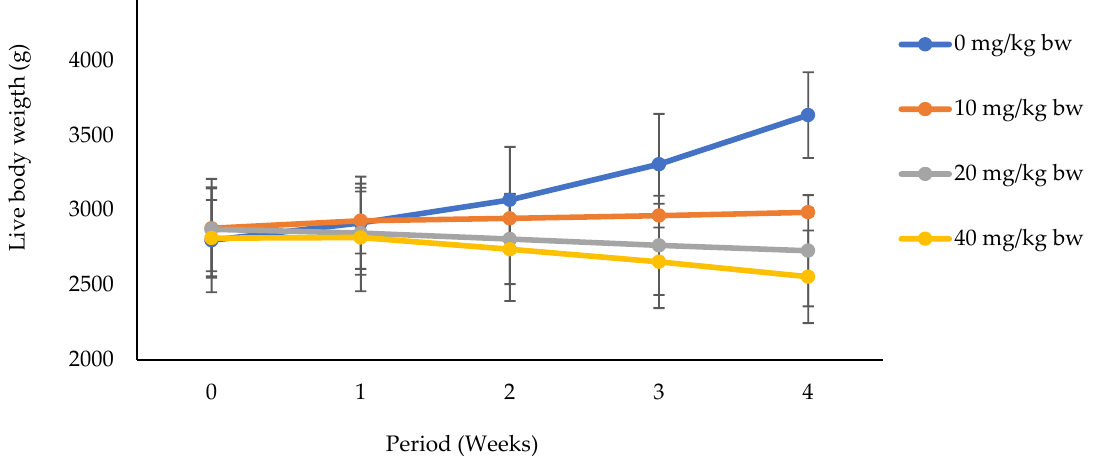
Figure 1. Weekly evolution of live weight in rabbit does exposed to potassium dichromate with 0, 10, 20, and 40 mg/kg bw doses of potassium dichromate.